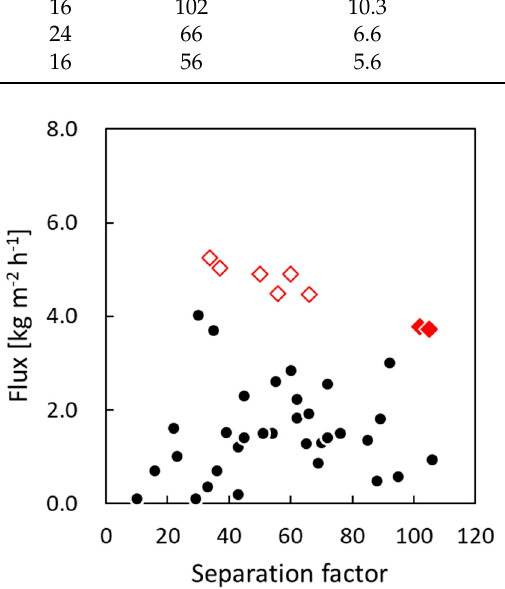
Figure 5. Relationship between the separation factor ( α ) and the flux through silicalite-1 membranes during separation of ethanol/water mixtures ( ● : hydrothermal synthesis [3–21]; : gel-free SAC (uncoated silica support) [22]; (cid:117) : gel-free SAC (silica-particle-coated silica support)).